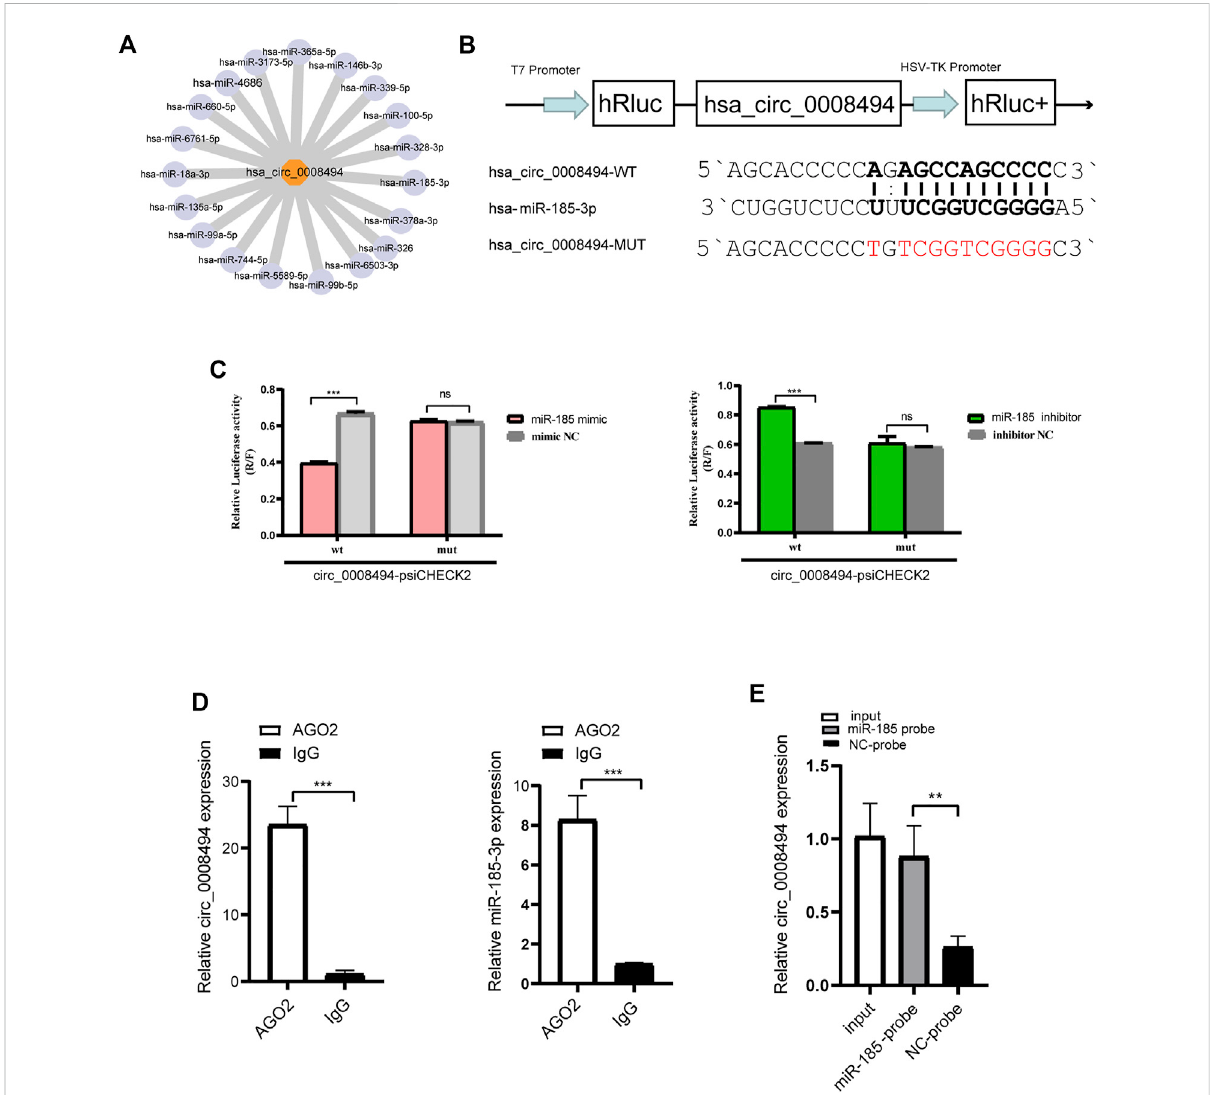
FIGURE 4 circ_0008494actsasaspongeofmiR-185-3p (A) miRandaalgorithmspredictedthebindingmiRNAsofcirc_0008494 (B) psiCHECKluciferase reporter plasmid was used to construct circ_0008494-WT-psiCHECK and circ_0008494-MUT-psiCHECK (C) Dual-Luciferase reporter gene assay veri fi ed the binding relationship between circ_0008494 and miR-185-3p (D) Association of circ_0008494 and miR-185-3p with AGO2. Cellular lysates of LX-2 were used for the RIP assay with an AGO2 antibody (IgG as control). circ_0008494 and miR-185-3p levels were detected by qRT-PCR assay (E) Biotin-coupled miRNA capture assay was constructed to verify the binding between circ_0008494 and miR-185-3p using a biotinylated miR-185-3p probe and a miRNA NC probe. The RNA levels were normalized to total GAPDH. Statistical analysis: Student t -tests. ** and *** stand for p < 0.01 and p < 0.001, respectively. ns, nonsigni fi cant. Experiments were repeated independently three